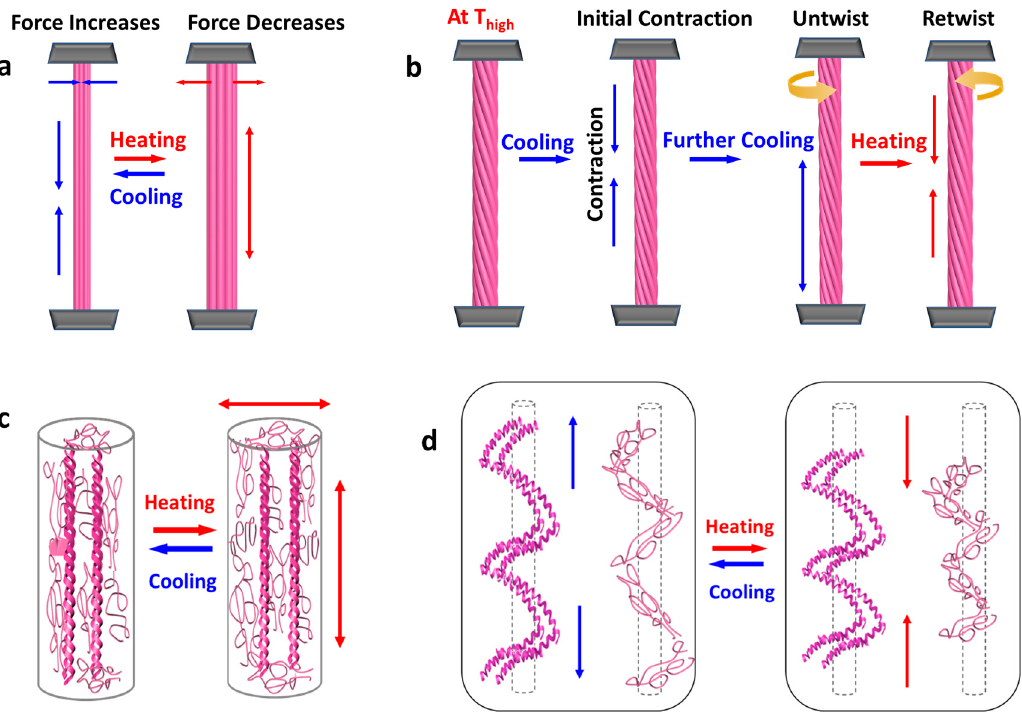
Figure 2. ( a ) Thermal expansion of raw wools in the parallel structure. ( b ) Untwisting and retwisting manner of wools in the twisted structure. ( c ) Cylindrical two-phase model of an α -keratin fibers in thermal conditions. ( d ) Conformational entropy changes of both alpha-helices and the amorphous matrix in the twisted structure.